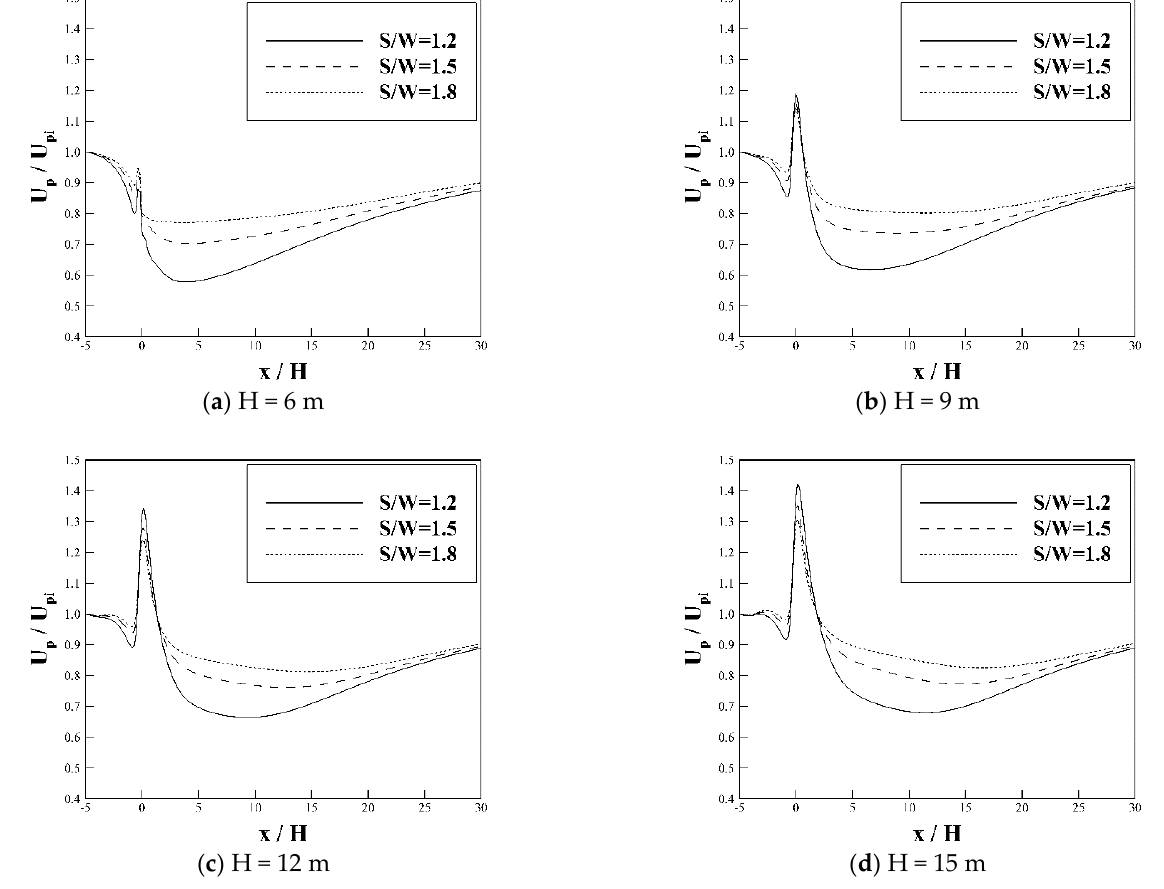
Figure 14. Stream-wise variations of averaged pedestrian wind speeds at different tree heights. By examining the magnitudes of the maximum pedestrian wind speeds at different tree heights and spaces, Figure 15 shows that the magnitude of the local wind speed max- ima appears insensitive to the change of the tree distance when H = 6 m. When the trees are taller, however, the value of the maximum wind speed becomes greater as the tree height increases or the tree space decreases. On the other hand, Figure 16 illustrates the locations and magnitudes of the downstream minimum pedestrian wind speeds. In the cases of 6 m tree height, the location of minimum wind speed appears nearly independent of the tree space. When the tree becomes taller, the minimum value occurs further down- stream with increases of the tree height and tree space. Meanwhile, the magnitude of the